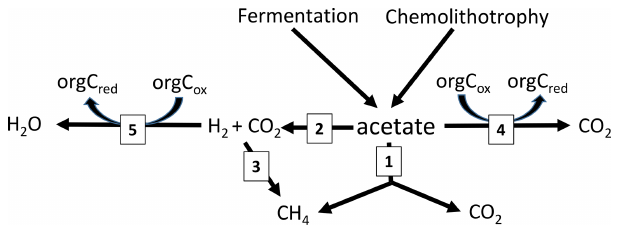
Figure 5. Scheme of the pathways involved in acetate turnover in sediments of Amazonian lakes: (1) acetoclastic methanogenesis, (2) syntrophic acetate oxidation, (3) hydrogenotrophic methanogen- esis and (4) acetate oxidation with organic electron